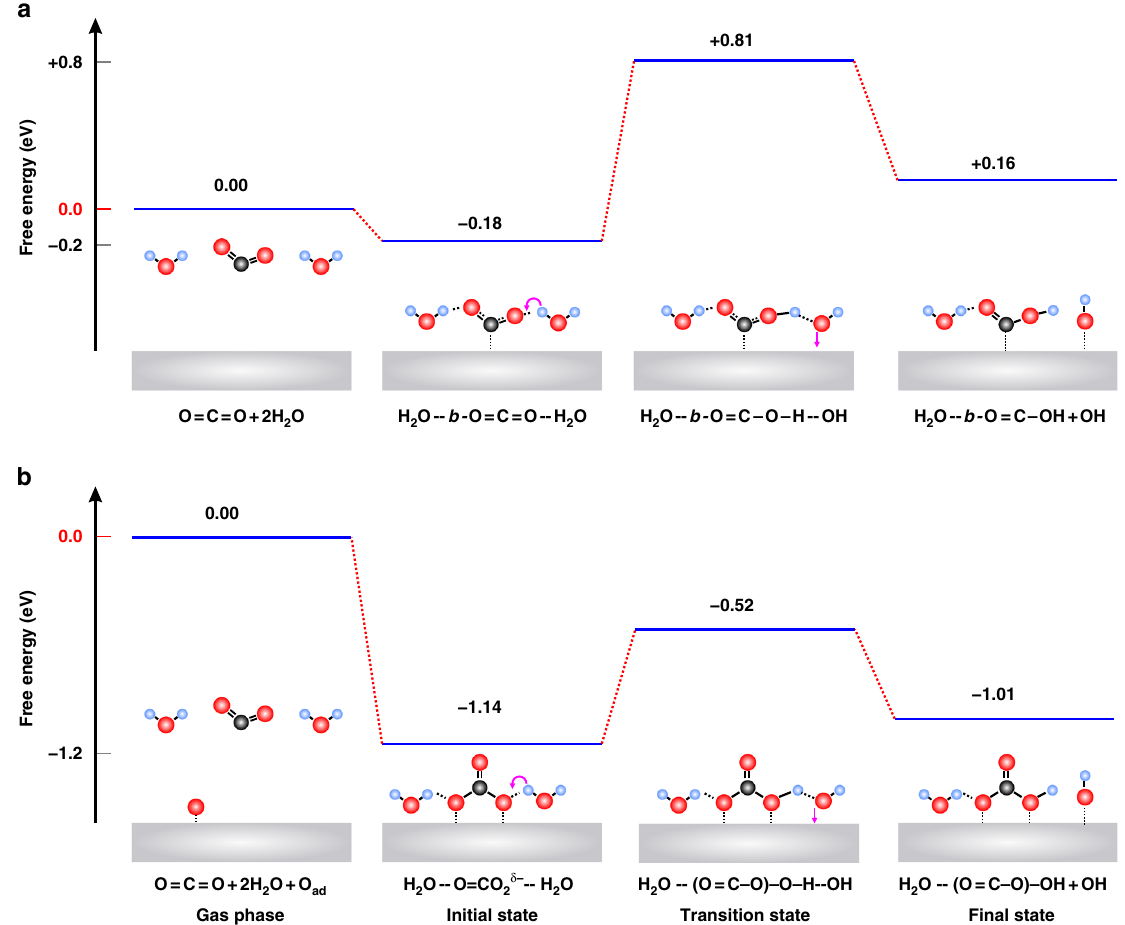
Fig. 5 The QM predicted kinetic pathway for the CO 2 hydrogenation process from full explicit solvent calculations. a The reaction pathway starting with b- CO 2 , the energy level of each step is referenced to g- CO 2 and g- H 2 O; b The reaction pathway starting with O = CO 2 δ − , the energy level of each step